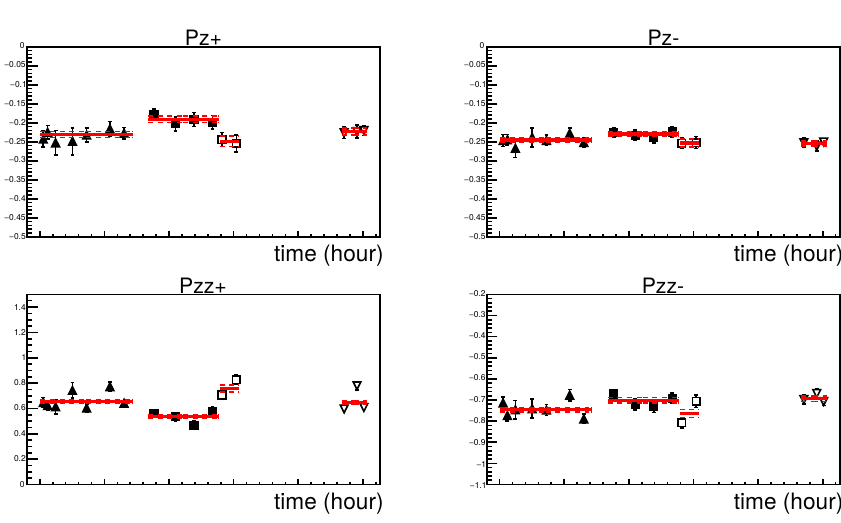
Figure 4. Polarizations values during the runs in 2016 and 2017 yy Table 1. The vector and tensor polarizations for di ff erent spin modes Polarization values ( p z , p zz